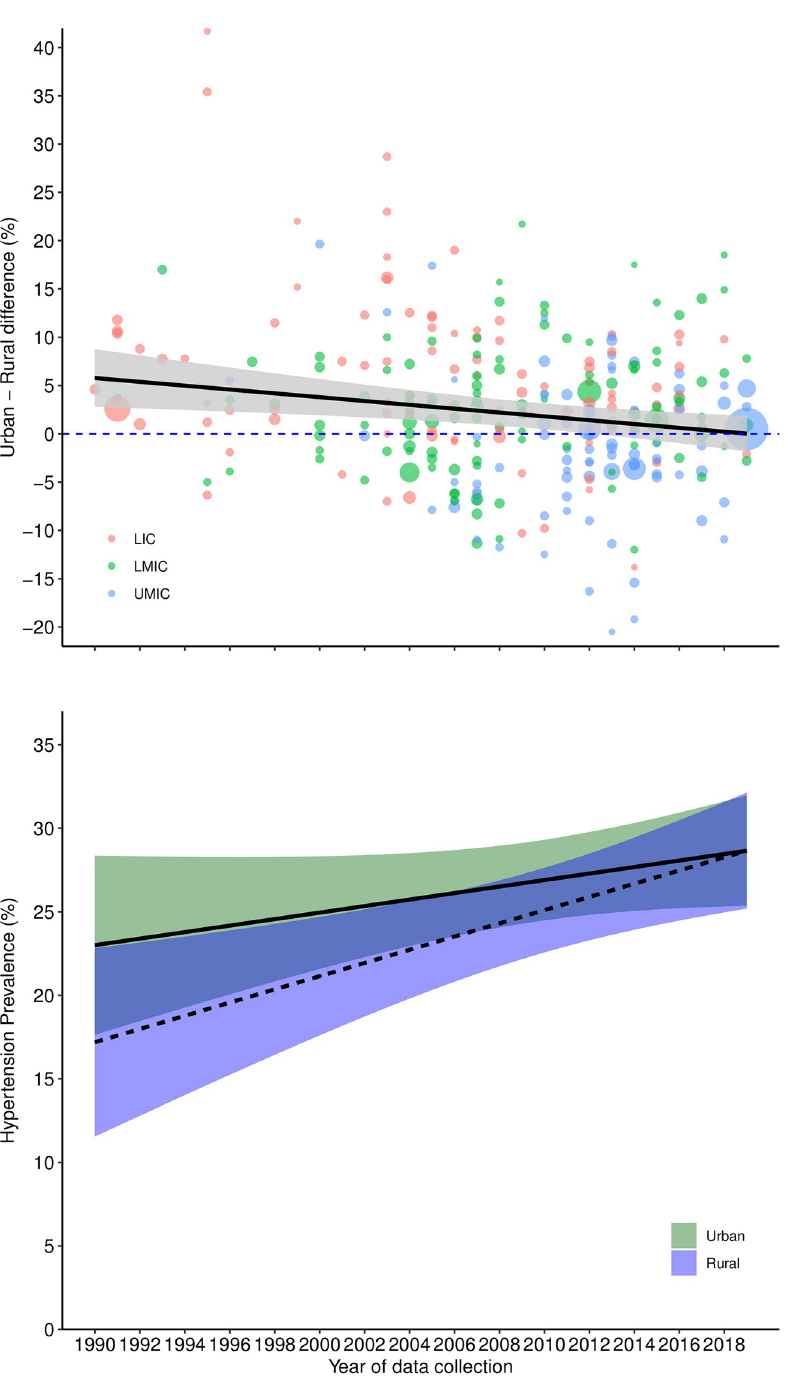
Fig 2. Urban-rural difference in hypertension prevalence from 1990 to 2020. Predicted urban-rural differences from a meta-regression model with year of start of data collection and 5 study-level features: use of population groups to define urban and rural areas, number of blood pressure readings, sampling bias, detection bias (urban/rural), and prevalence adjusted by age/sex/sampling weights. The plot shows the prediction (marginal mean from model-5) of this model varying year from 1990 to 2019 (year starting data collection) and setting the 5 study-level features to the least biased category (no use of groups, � 2 readings, probably low risk of sampling bias, probably low risk of detection bias (urban/rural), and adjusted prevalence). Income country status is only to illustrate each survey, and it is not adjusted in the model. Shaded areas represent 95% confidence interval and circle sizes proportional to inverse of variance. In the bottom panel, the solid lines represent urban areas and dashed lines represent rural areas. LIC, low-income country; LMIC, lower-middle-income country; UMIC, upper-middle-income country. https://doi.org/10.1371/journal.pmed.1004079.g002 PLOS Medicine| https://doi.org/10.1371/journal.pmed.1004079 August 25,